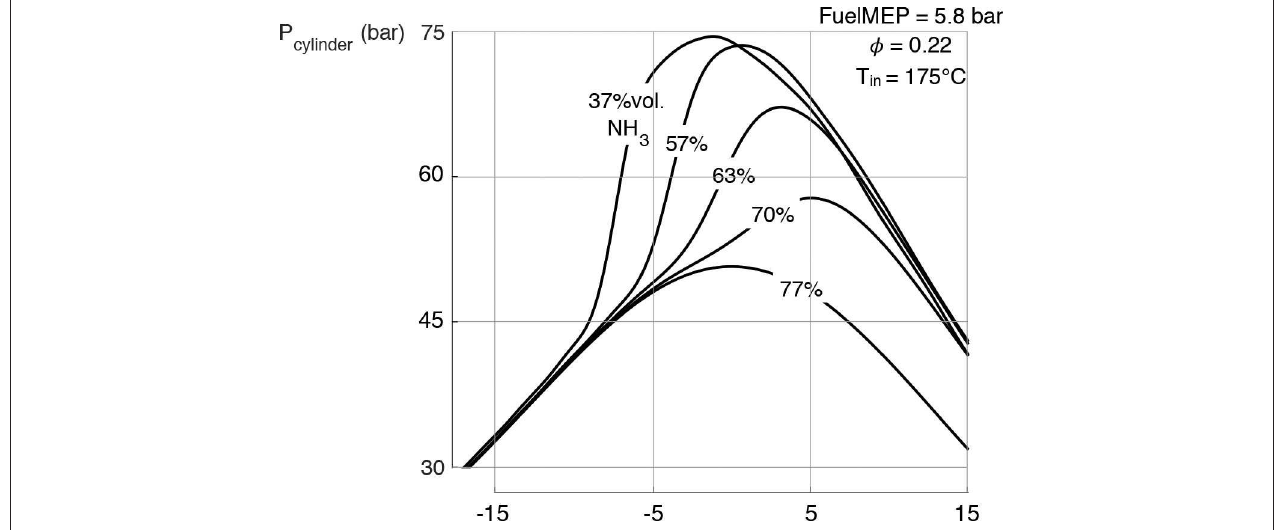
FIGURE 8 | The combustion is delayed as the ammonia fraction is increased in the set #1, with constant FuelMEP, equivalence ratio and intake temperature.